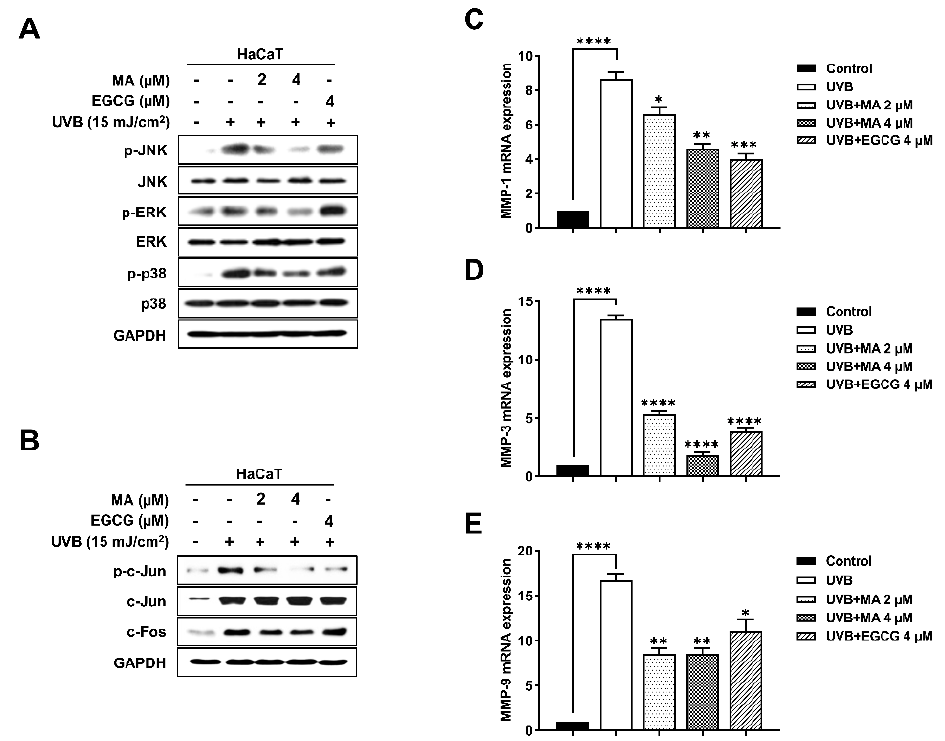
Figure 4. Effect of malonic acid (MA) on ultraviolet (UV) B-induced mitogen-activated protein kinase/activator protein 1 (MAPK/AP-1) signaling and matrix metalloproteinase (MMP) mRNA expression in UVB-irradiated HaCaT cells. ( A – E ) HaCaT cells have been treated with MA for 4 h and then exposed to UVB irradiation (15 mJ/cm 2 ). After an overnight incubation following UV exposure, phosphorylation of ( A ) MAPK signaling (extracellular signal-regulated kinase [ERK], c-Jun N-terminal kinase [JNK], and p38) and ( B ) AP-1 complex (c-Jun and c-Fos) are assessed using western blot analysis. Glyceraldehyde 3-phosphate dehydrogenase (GAPDH) is used as an internal control for western blot analysis. Epigallocatechin-3-gallate (EGCG) is used as a positive control. ( C – E ) UVB-induced MMP expression in HaCaT cells. The expression of mmp-1 ( C ), mmp -3 ( D ), and mmp-9 ( E ) mRNA, as measured using real-time polymerase chain reaction (PCR). +, - means UVB irradiation or non-irradiation and treatment or non-treatment of MA and EGCG. The data were analyzed in triplicate and displayed as the mean ± the standard error of the mean (SEM). (*) p < 0.05, (**) p < 0.01, (***) p < 0.001, and (****) p <